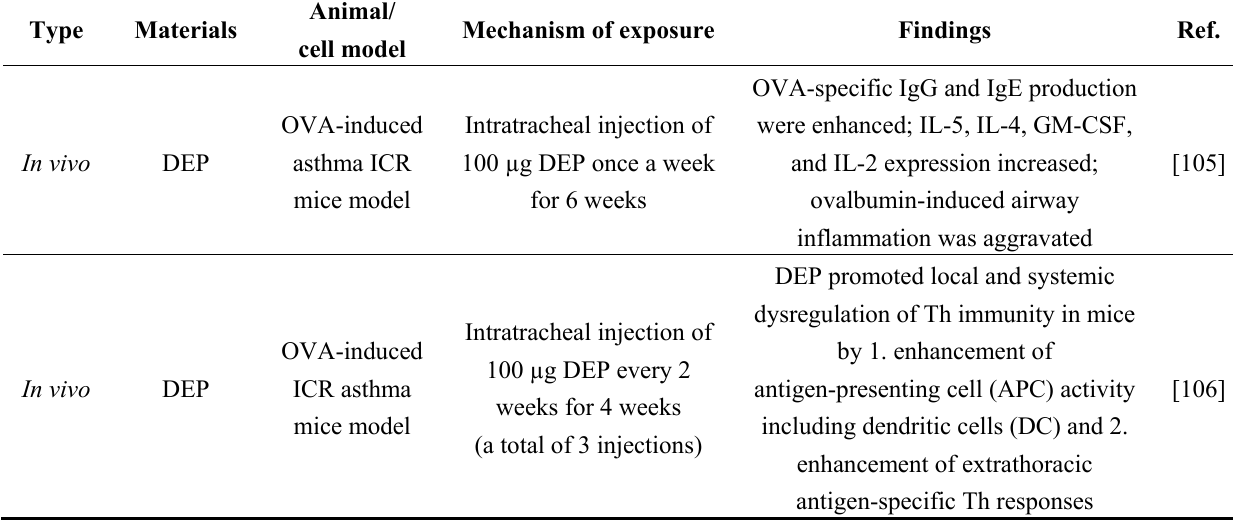
Table 5. Studies of nanoparticle toxicity in asthma